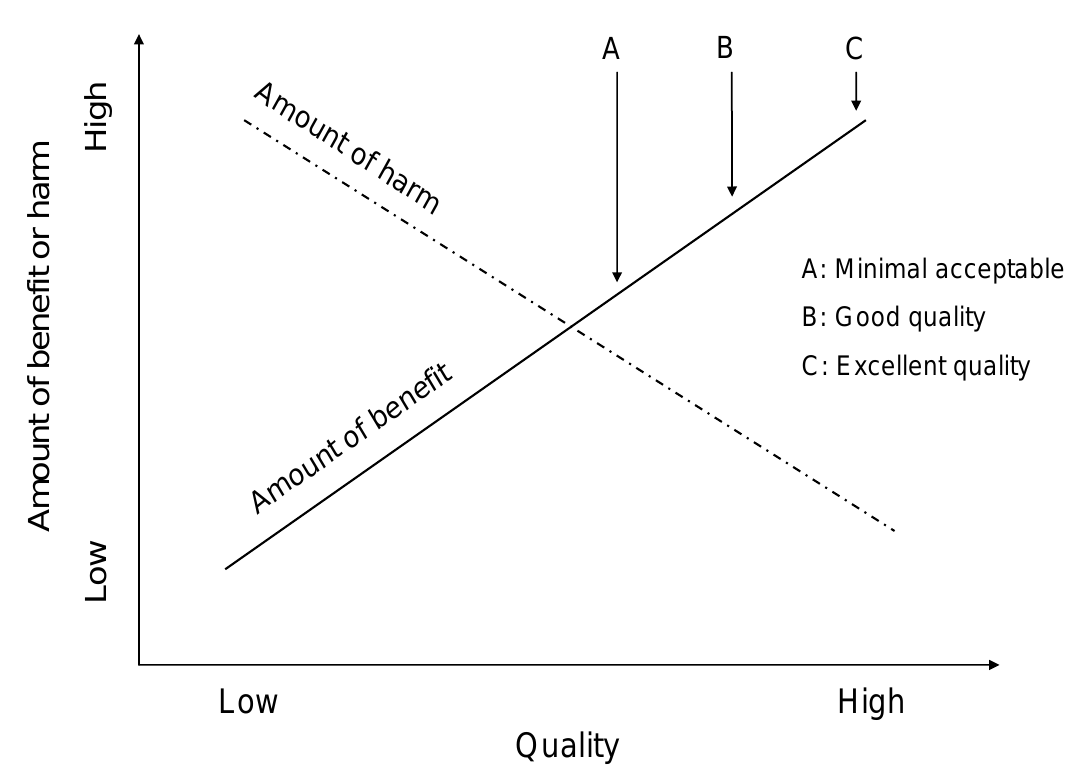
The balance of benefits, harm and